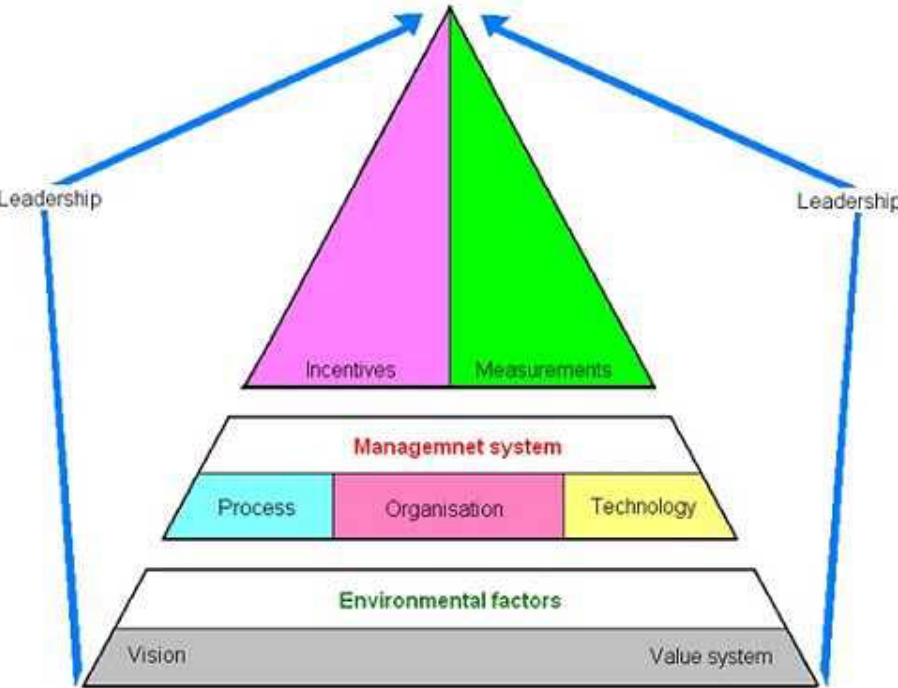
Figure 2 Skandia Navigator (Source: Skyrme and Amidon